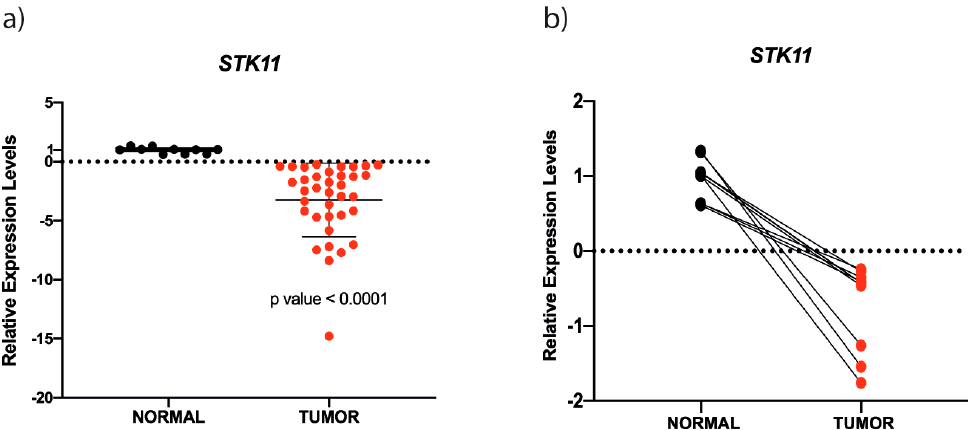
Figure 1. STK11 is down ‐ expressed in HNC samples . ( a ) Expression levels of STK11 determined by qRT ‐ PCR in HNC samples (red circles) and healthy tissue samples (black circles). STK11 was 5 ‐ fold down ‐ expressed in HNC tumors compared to control tissue. The statistically significant difference is indicated by p ‐ values ( p ‐ value < 0.0001). ( b ) Matched expression of healthy adjacent tissue and its tumor counterpart.